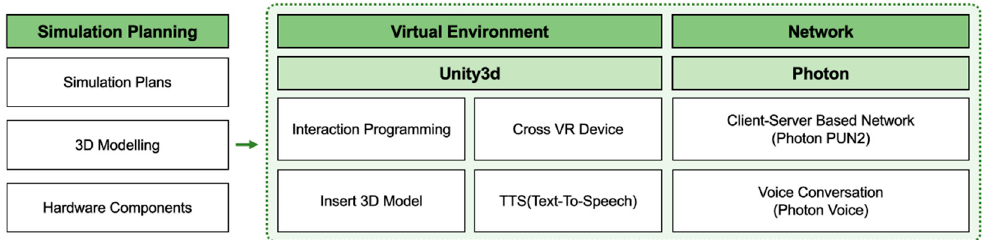
Figure 1. Proposed system development environment.